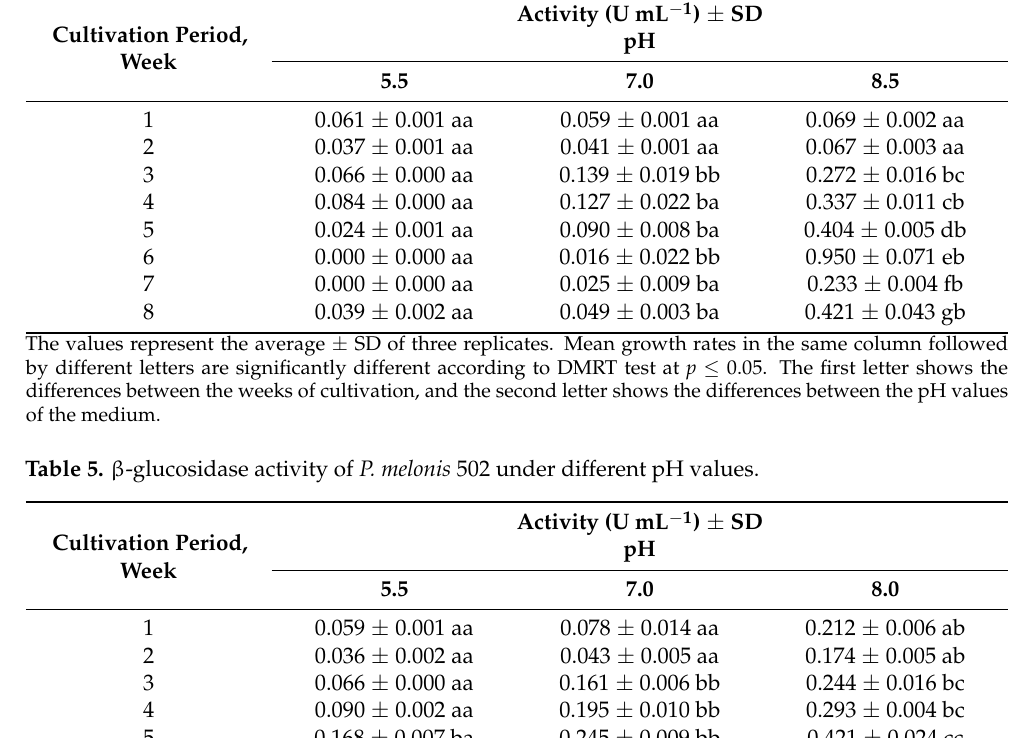
Table 4. Endoglucanase activity of P. melonis 502 under different pH values. Cultivation Period,